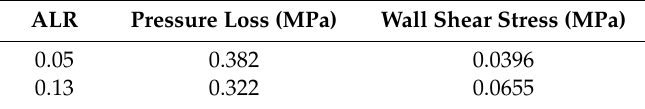
Table 2. Pressure loss and wall shear stress values at the nozzle wall for a liquid viscosity of 0.39 Pa · s and two di ff erent ALR: 0.05 and